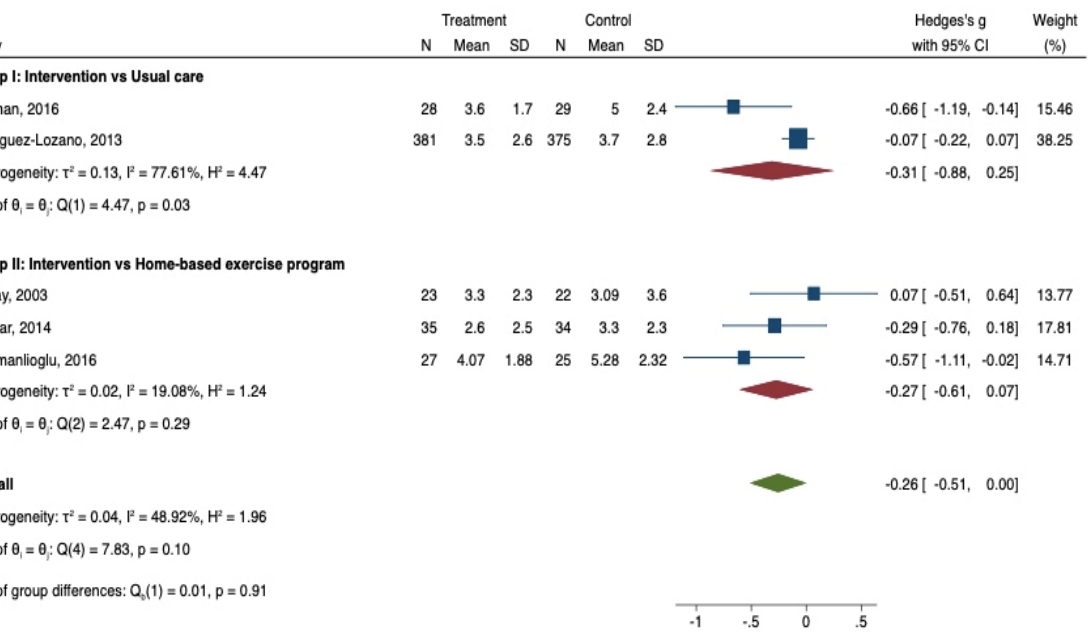
Figure 6. VAS—Forest Plot.